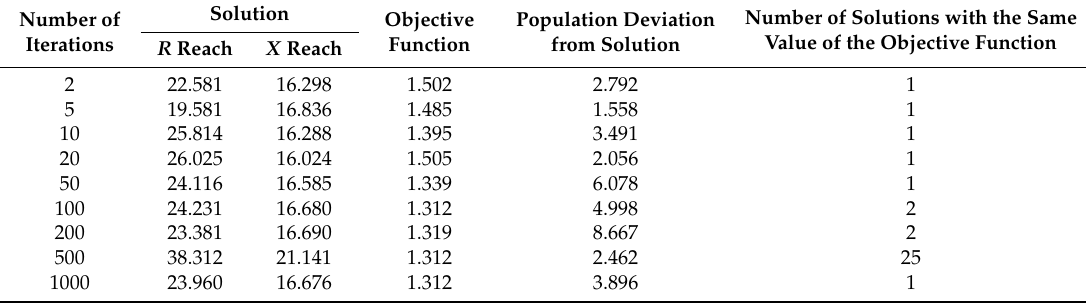
Table 8. Performance tests of the GA with a preference factor k = 0.95 and a mutation rate of 0.1. Solution Objective Number of Population Deviation Iterations Function from Solution